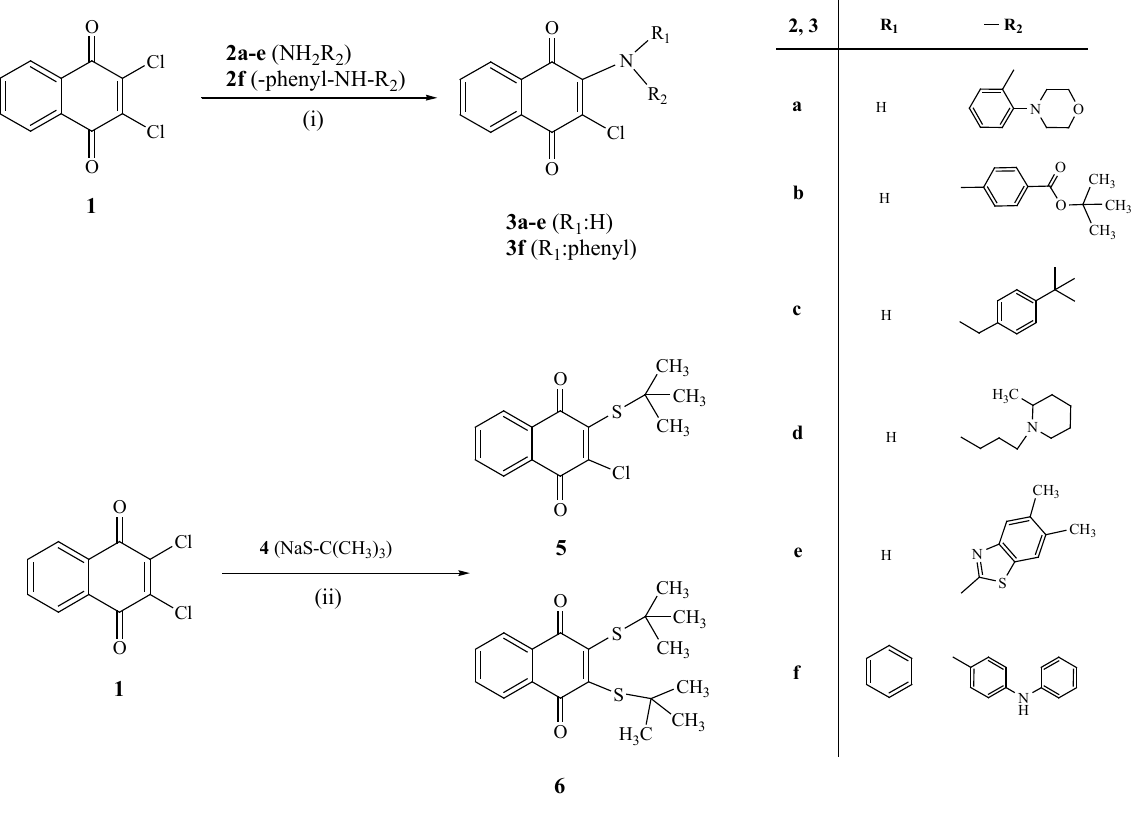
Figure 1: Characterization of quinonoid protons H substituted 1,4-naphthoquinones ( 3a-f